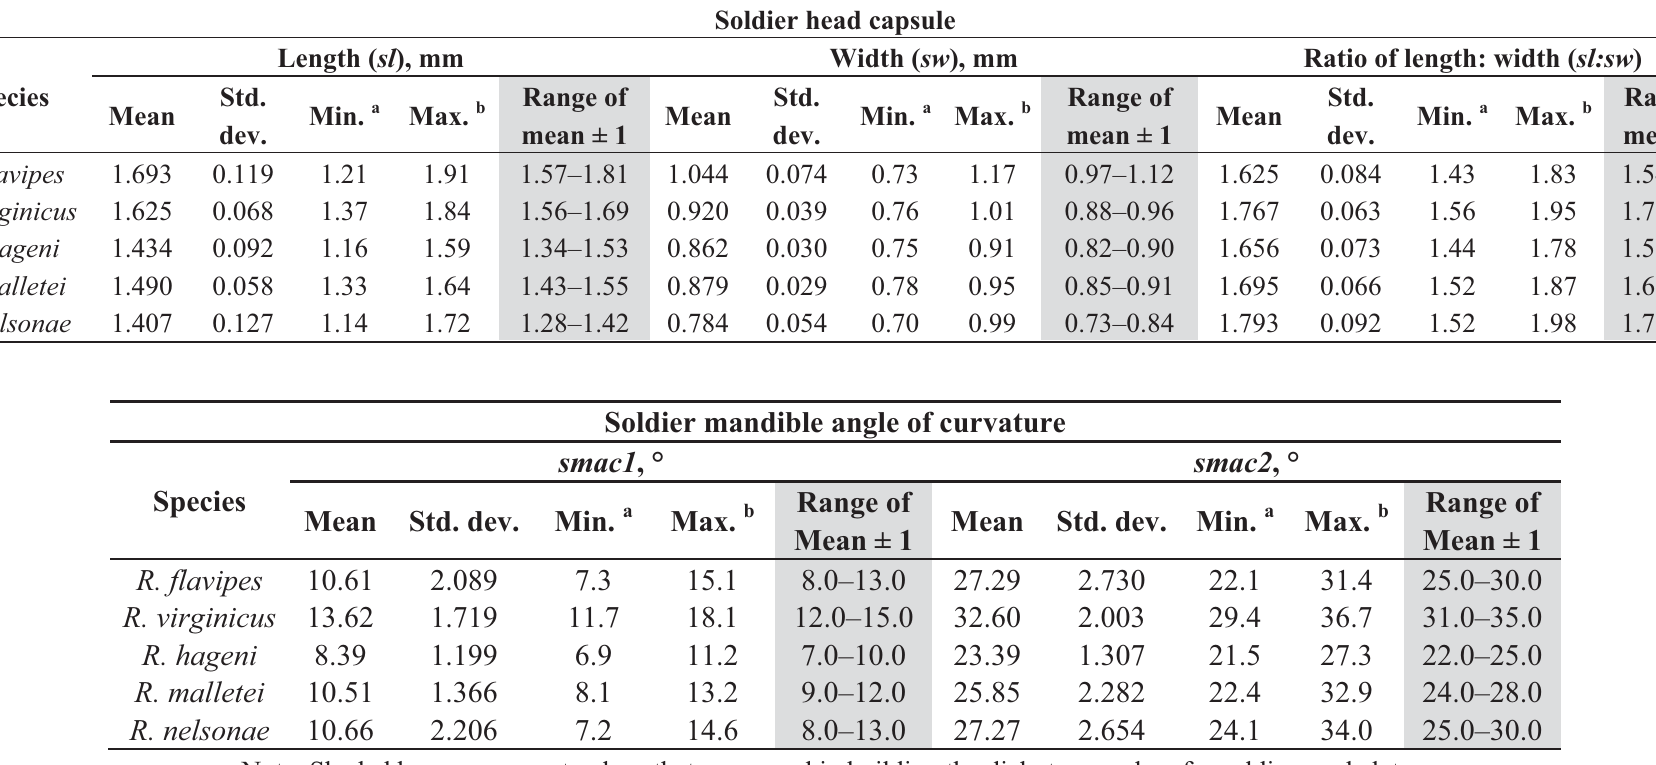
Table 4a. List of soldier characters measured by species showing mean, standard deviation, range of values and range of mean ± one std. dev.